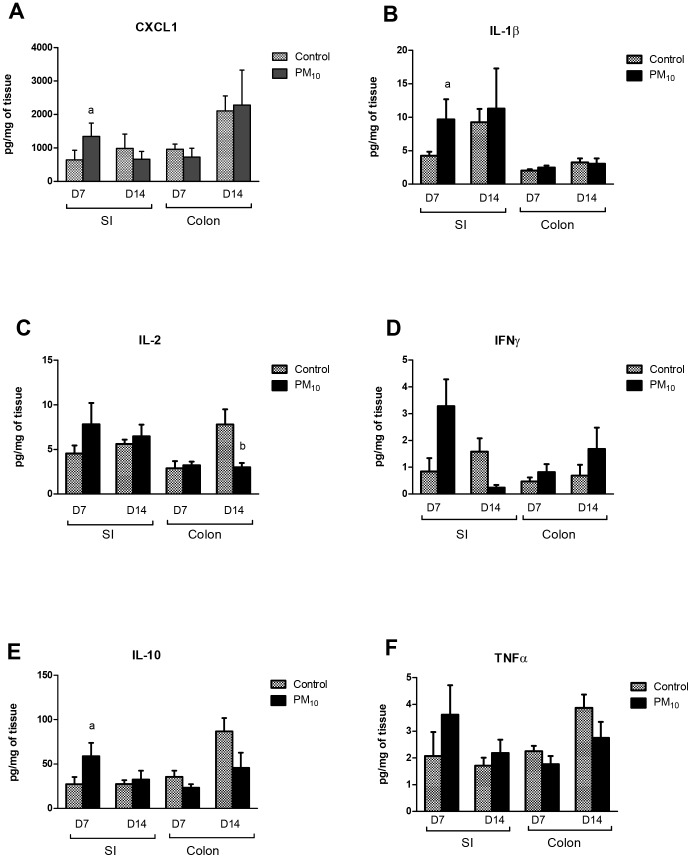
Cytokine secretion from isolated small intestine (SI) and colon taken from WT mice treated with PM10 for 7 (D7) or 14 (D14) days.A significant increase in CXCL1 (A), IL-1β (B) and IL-10 (E) was seen in the small intestine at day 7. Bars are mean ± SEM n = 6 for all groups a p<0.05 compared with control at day 7; bp<0.05 compared with control at day 14.